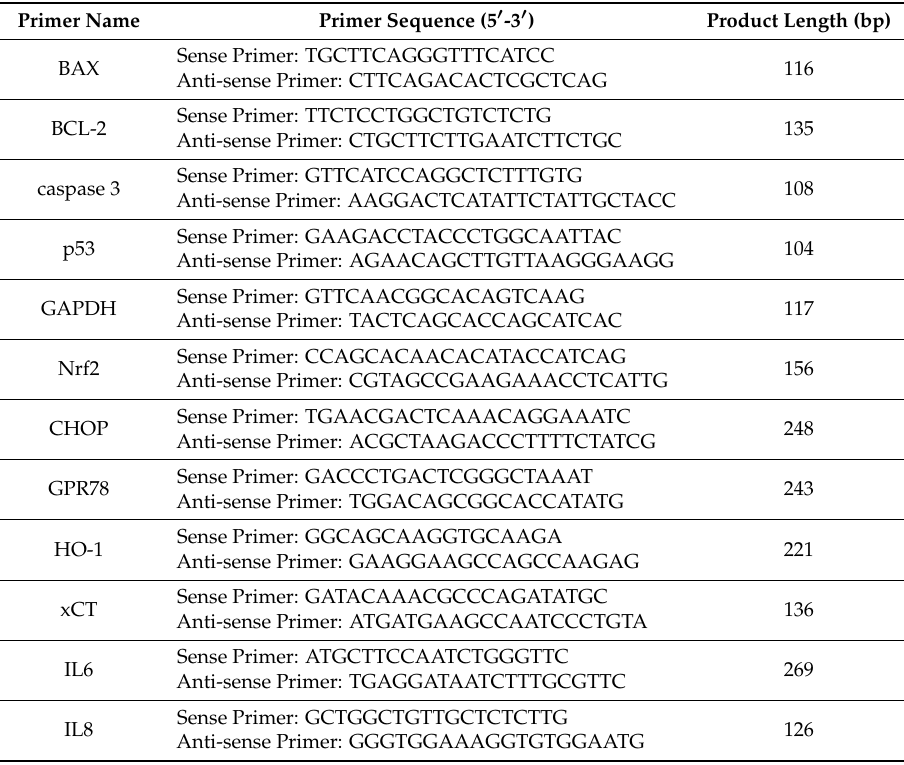
Table 1. Primers for real-time quantitative